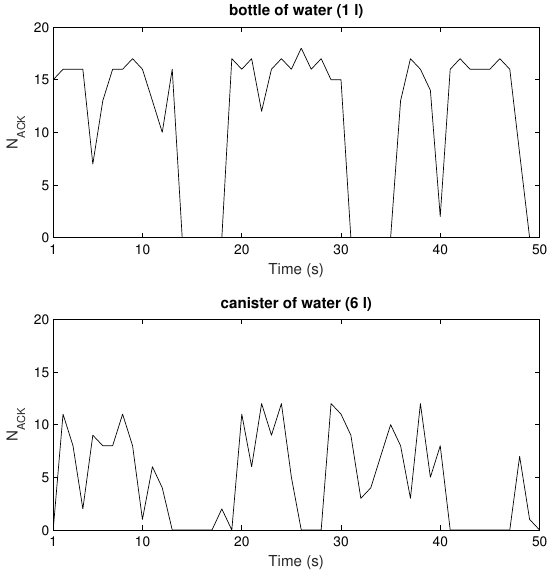
Figure 16. Sniffer measurements of tag responses when attached on water products of different